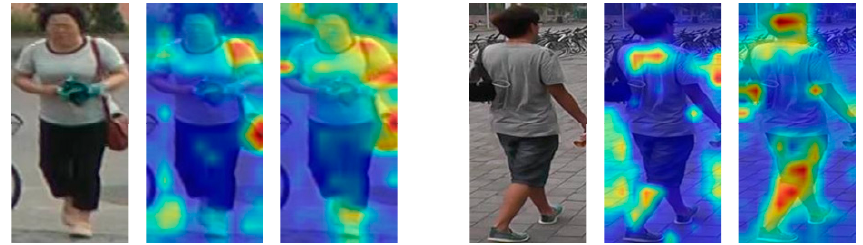
Figure 6. Activation visualisation results. From left to right: original image, setting 4, and CAP.